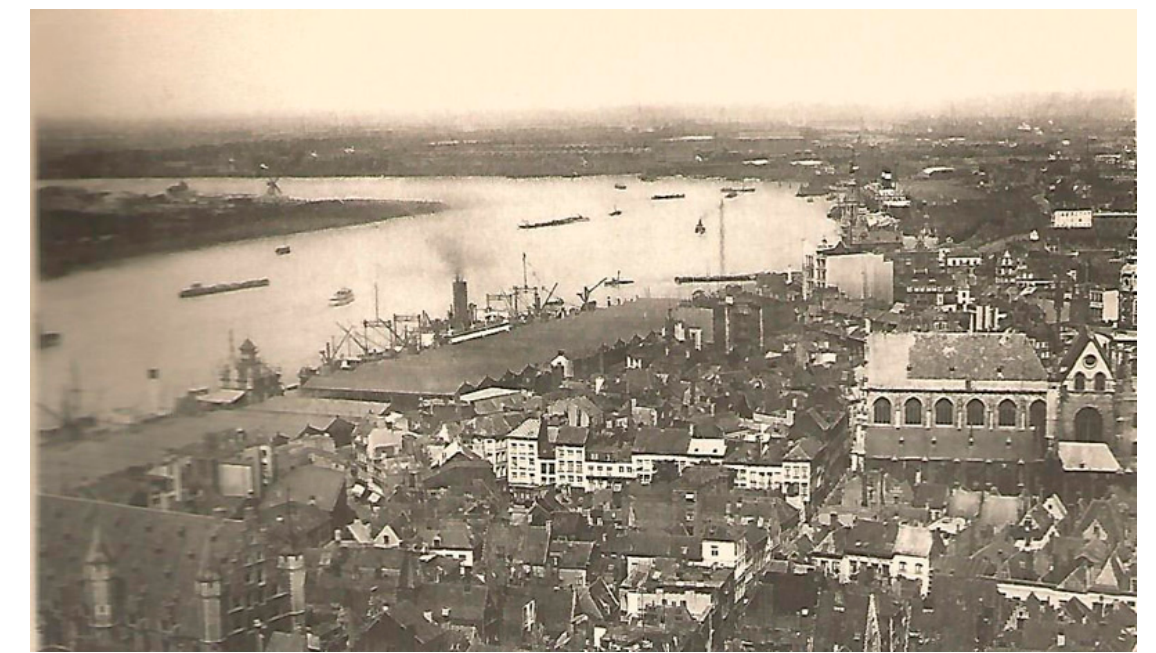
Figure 4. Antwerp—an industrious historic city, 1863.